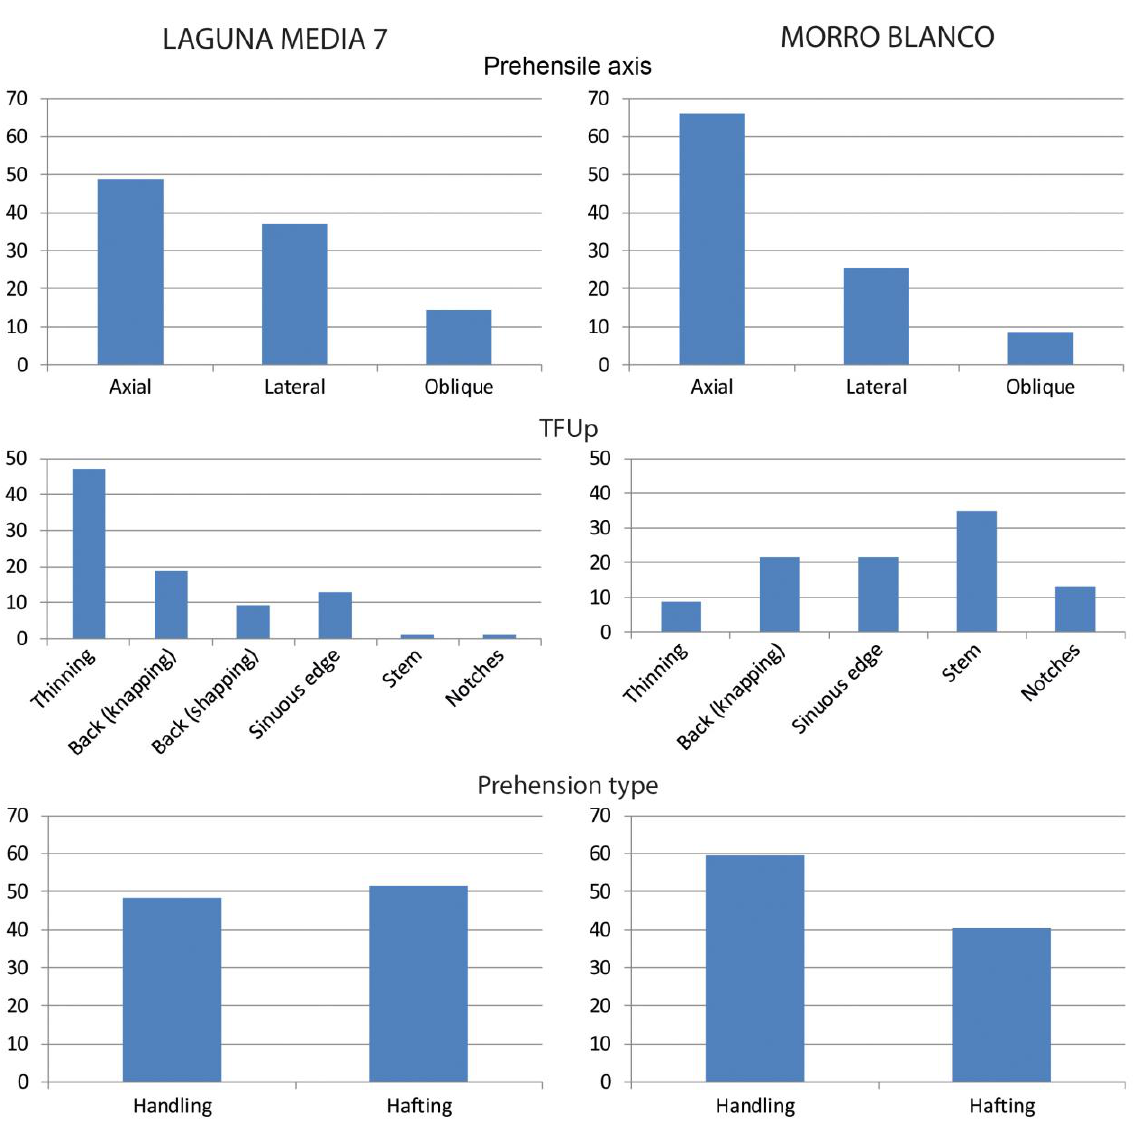
Figure 8. Distribution (percentages) of prehensile axis, prehension type and TFU